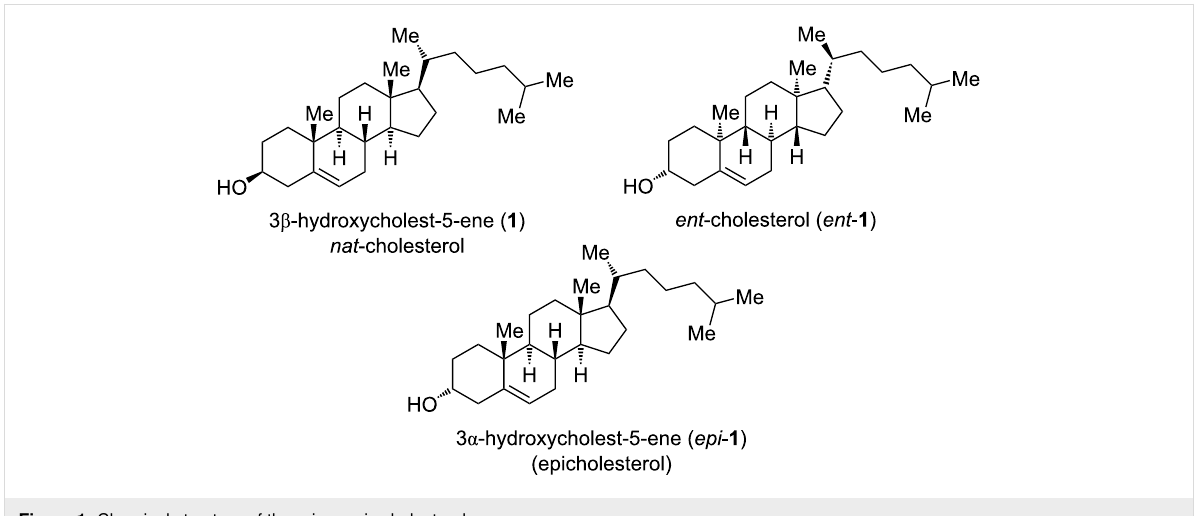
Figure 1: Chemical structure of three isomeric cholesterols.